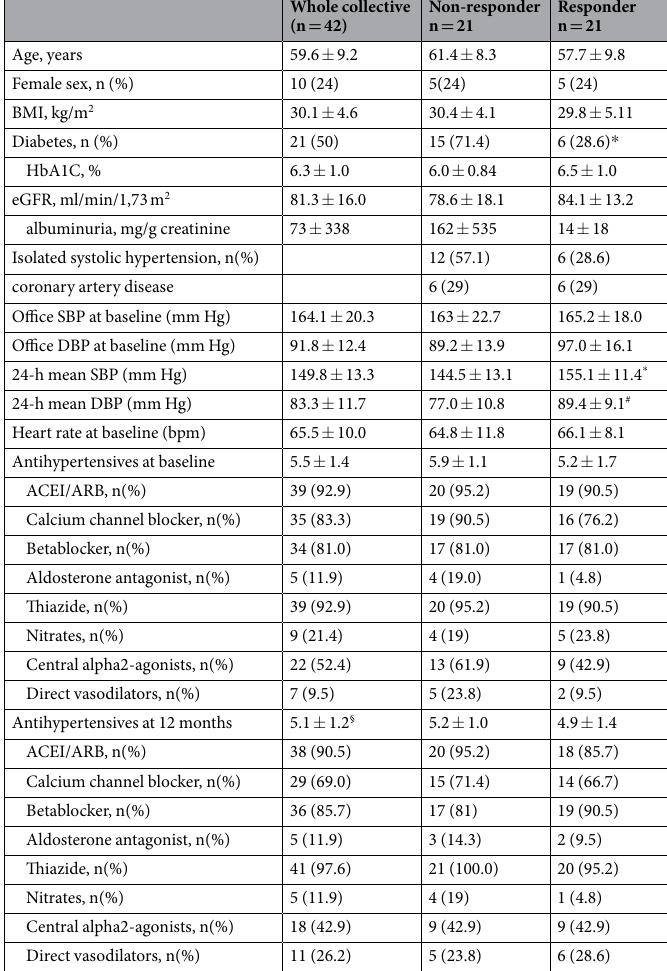
Table 1. Demographic and clinical characteristics of the study collective (n = 42). ACEI- angiotensin converting enzyme inhibitor; ARB- angiotensin receptor blocker; BMI- body mass index; DBP- diastolic blood pressure; SBP- systolic blood pressure; * statistically significant difference compared to non-responder (p < 0.01); # statistically significant difference compared to non-responder (p < 0.001); § statistically significant difference compared to the number of antihypertensives at baseline (p <